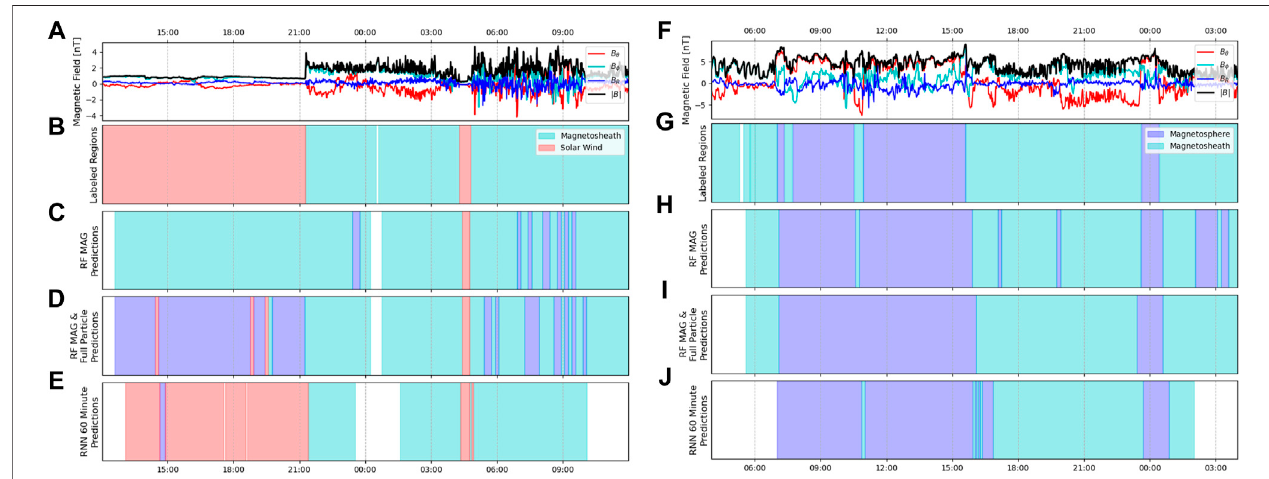
FIGURE 8 | An example BS crossing is shown from 8 March 2008 (left column) and an example MP crossing is shown from 3 May 2008 (right column), coincident with the transitions shown in Figure 2 . Magnetic fi eld magnitude and KRTP components are shown (A,F) along with regions as denoted by the labeled MP and BS crossings (B,G) andthemodelpredictions fromthreeselectedmodels -RFMAG (C,H) ,RFMAG&fullion (D,I) ,and RNN MAG60-minmodel (E,J) .Timeperiodswhich do not have any predictions due to a lack of data are denoted by white. Ideally the time periods of the model-predicted regions would coincide directly with the labeledregions.Here,weseethattheRNN60-minmodelcomesclosesttothelabeledtestset,whiletheRFmodelspredictsigni fi cantlymoretransitions,andparticularly with the BS crossing, they are incorrect in their prediction of the solar wind